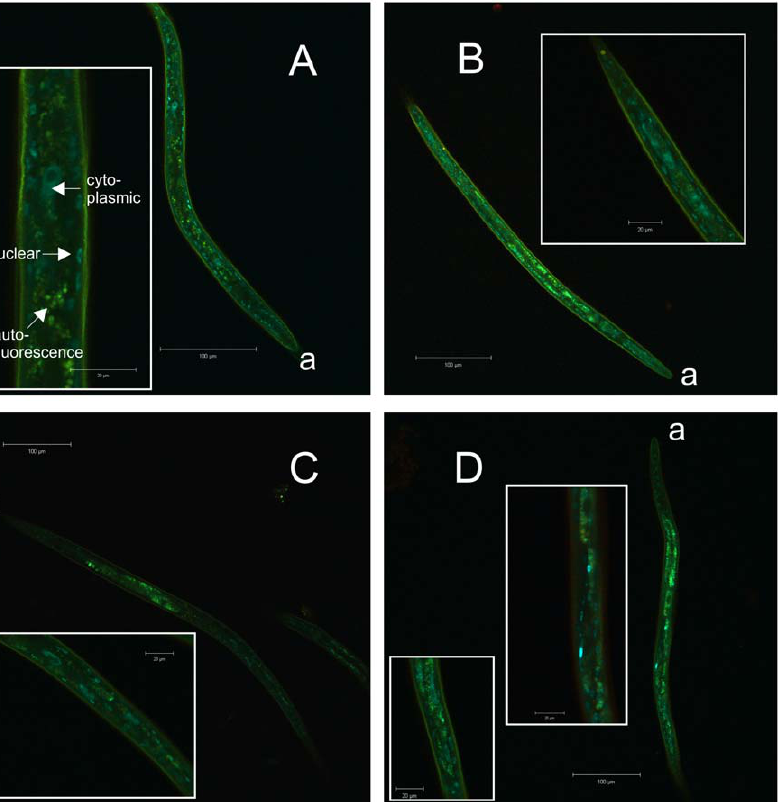
Figure 5. Cellular localization of Ac -DAF-16 wildtype and single AKT-phospho-mutants in dauer larvae. Pictures are lambda stack images from transgenic daf-2;daf-16 dauers, expressing fusion constructs of A ) Ac -DAF-16 wildtype, single mutants B ) Ac -DAF-16 (S107A), C ) Ac -DAF- 16 (T312A), D ) Ac -DAF-16 (S381A). ‘‘a’’ indicates the anterior end.